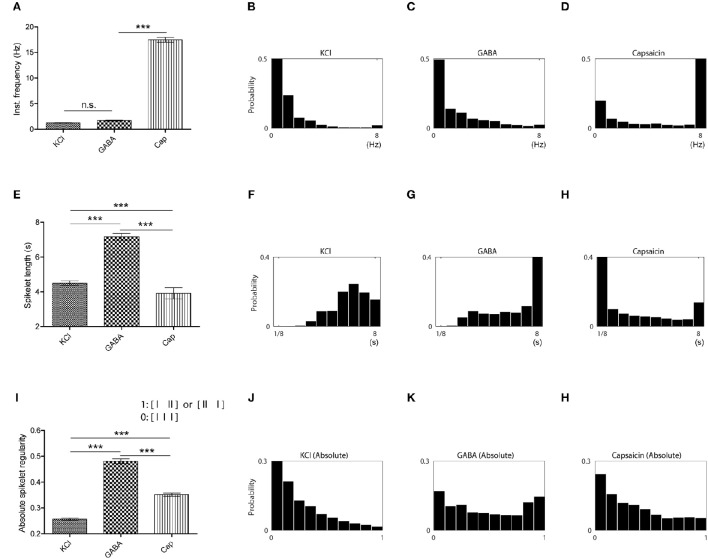
Temporal characteristics of the different stimuli revealed in spikelet distributions. (A) Comparison of instantaneous frequencies for KCl, GABA, and capsaicin responses. (Kruskal-Wallis one-way ANOVA followed by Dunn's test for multiple comparisons, ***P < 0.001, n.s., not significant.) (B–D) Instantaneous frequency histograms for each chemical (KCl in B, GABA in C and capsaicin in D). (E) Comparison of spikelet lengths for KCl, GABA, and capsaicin responses. (Kruskal-Wallis one-way ANOVA followed by Dunn's test for multiple comparisons, ***P < 0.001) (F–H) Spikelet length histograms for each chemical (KCl in F, GABA in G and capsaicin in H). (I) Comparison of spikelet regularity for KCl, GABA, and capsaicin responses. (Kruskal-Wallis one-way ANOVA followed by Dunn's test for multiple comparisons, ***P < 0.001.) (J–L) Spikelet regularity histogram for each chemical (KCl in J, GABA in K, and capsaicin in L). All the error bars represent s.e.m.